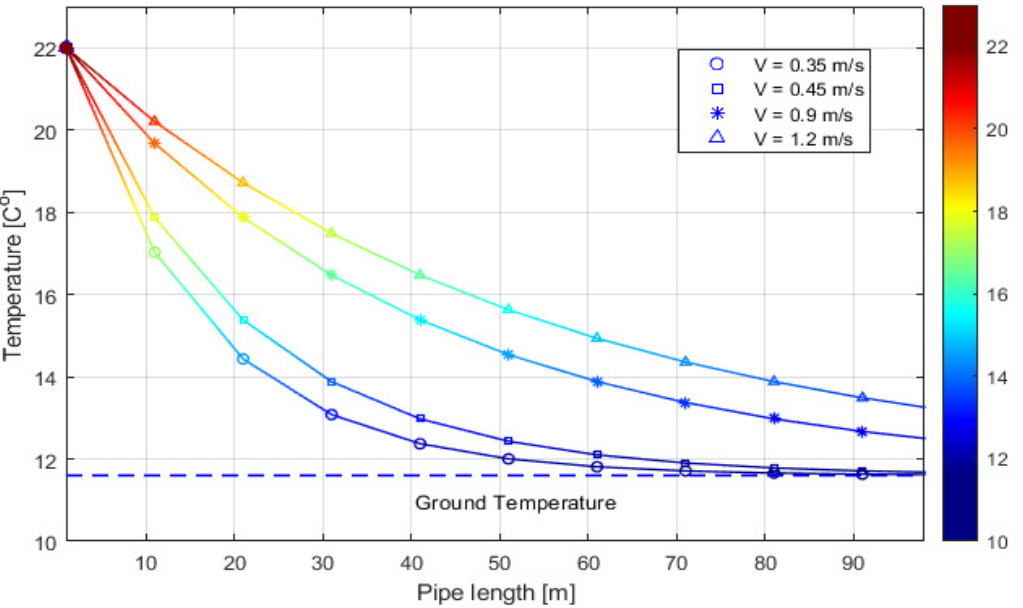
Figure 8. The water temperature behavior in a vertical single U-tube for cooling mode (in the summer) at different water velocities (0.35, 0.45, 0.9, and 1.2 m/s ).